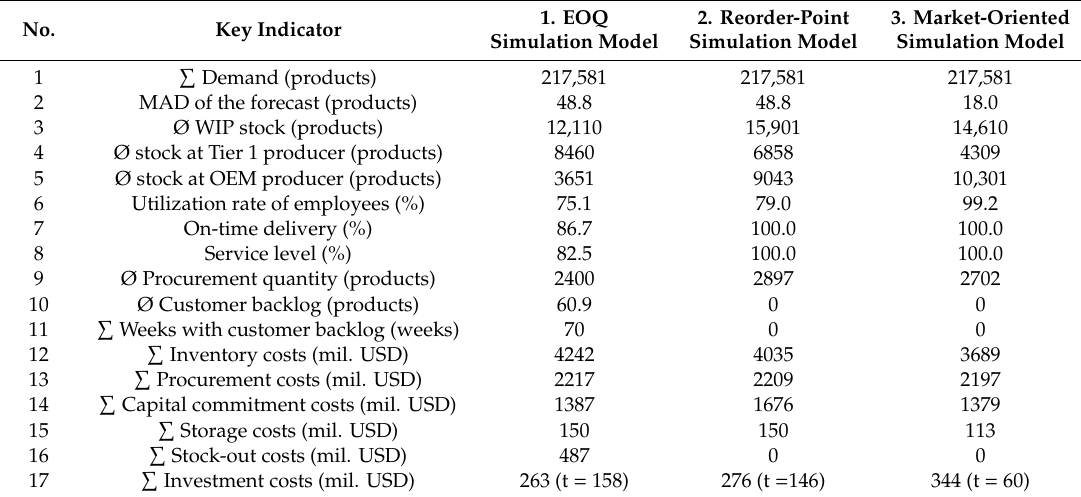
Table 12. Simulation results for the fourth demand scenario.